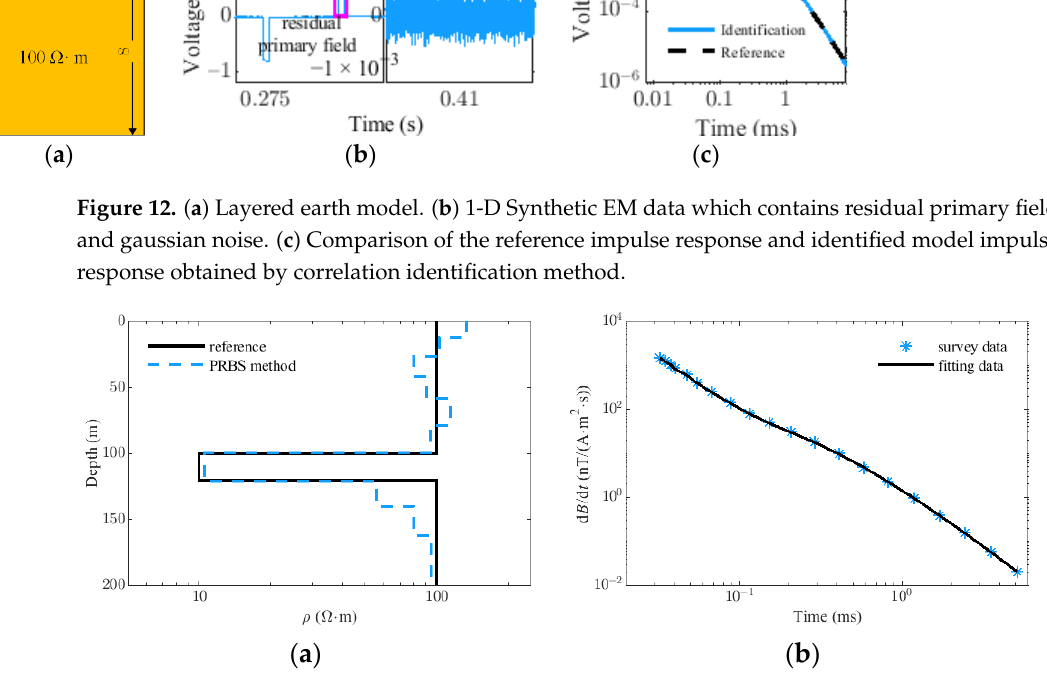
model and inversion model. ( b ) Response data and its inversion fitting data.